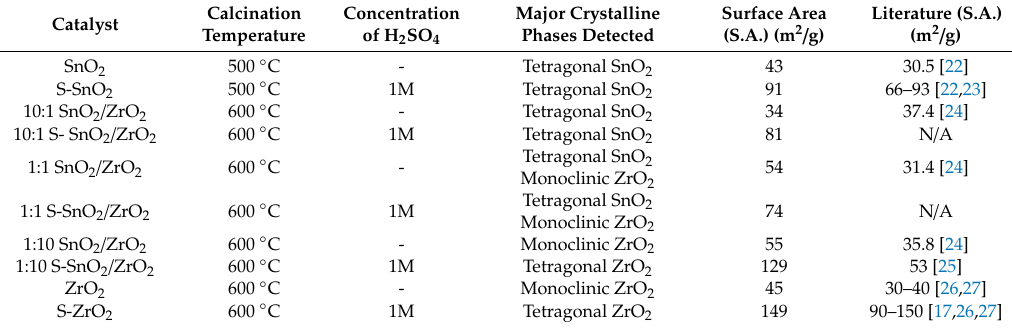
Table 1. Sulfation parameters, calcination temperature conditions, and physicochemical properties of all catalysts synthesized. Comparison of surface areas with relevant literature resources is also